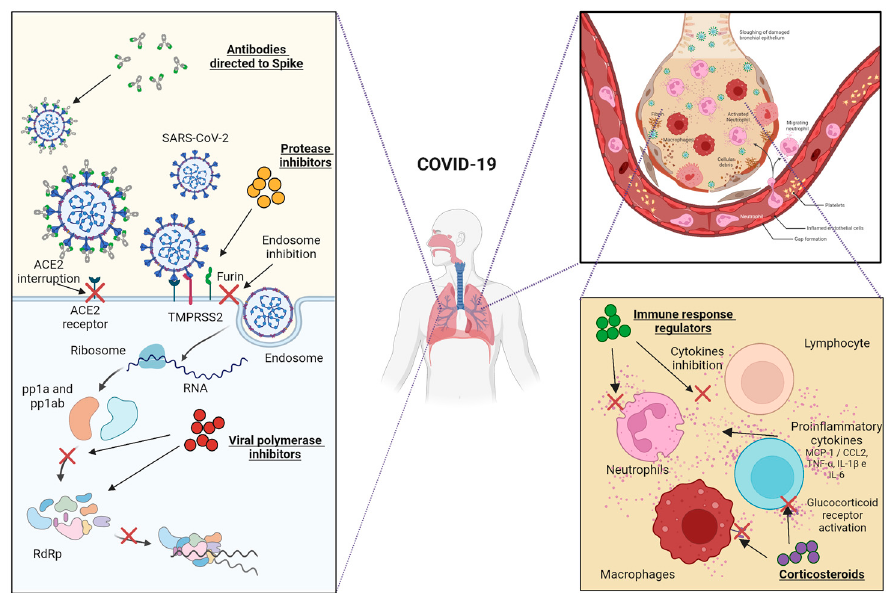
Figure 1. Primary mechanisms of potential COVID-19 drugs under development. The main mecha- nisms of action of the potential treatments against COVID-19 are schematized as follows: SARS-CoV-2 entry block (mediated by anti-Spike antibodies or protease inhibitors), replicative cycle arrest (mediated by viral polymerase inhibitors), and regulation of proinflammatory response (mediated by corticoids and other immune response regulators).